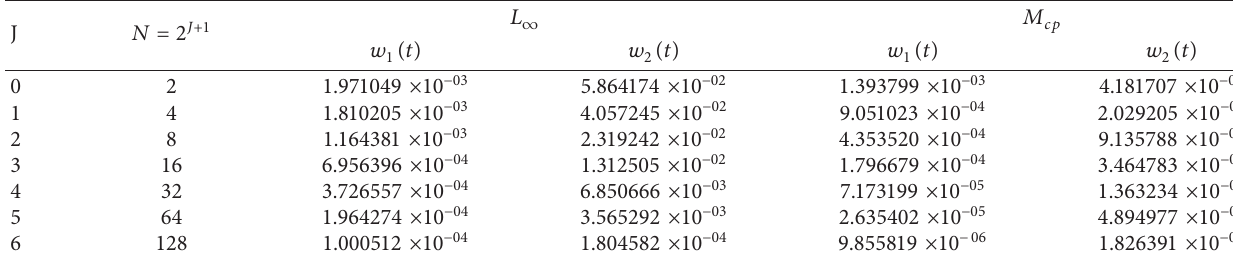
Table 2: L and M cp errors for Problem 2. ∞